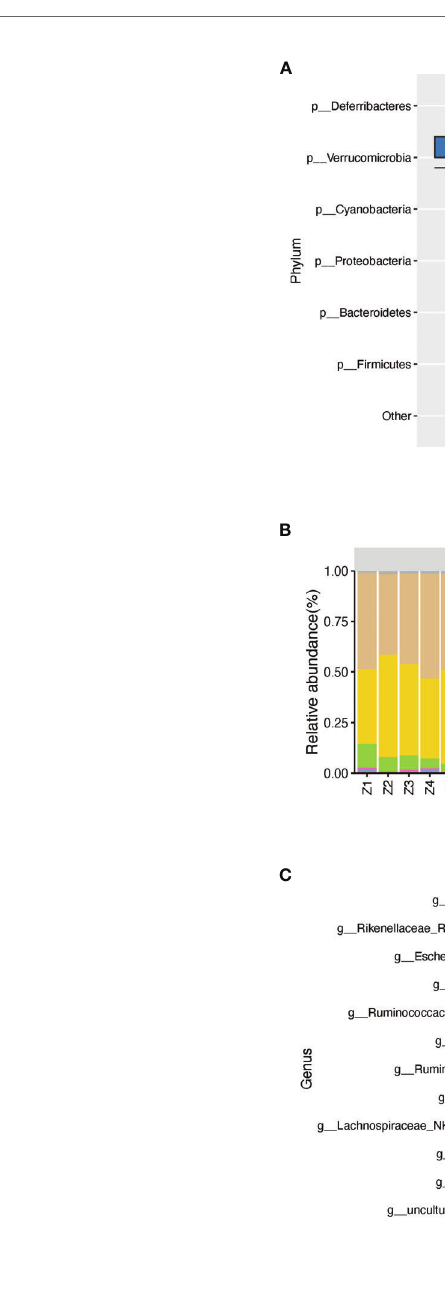
FIGURE 2 | The discrepant phyla (relative abundance of top 5) and genera (relative abundance of top 10) between SC and ST group. (A) Four distinct phyla were found between SC and ST group. (B) The barplot of composition of microbial community in SC and ST group. (C) Eight discrepant genera were sought out between SC and ST groups. *, and ** stand for the FDR-value <0.05, and <0.011,